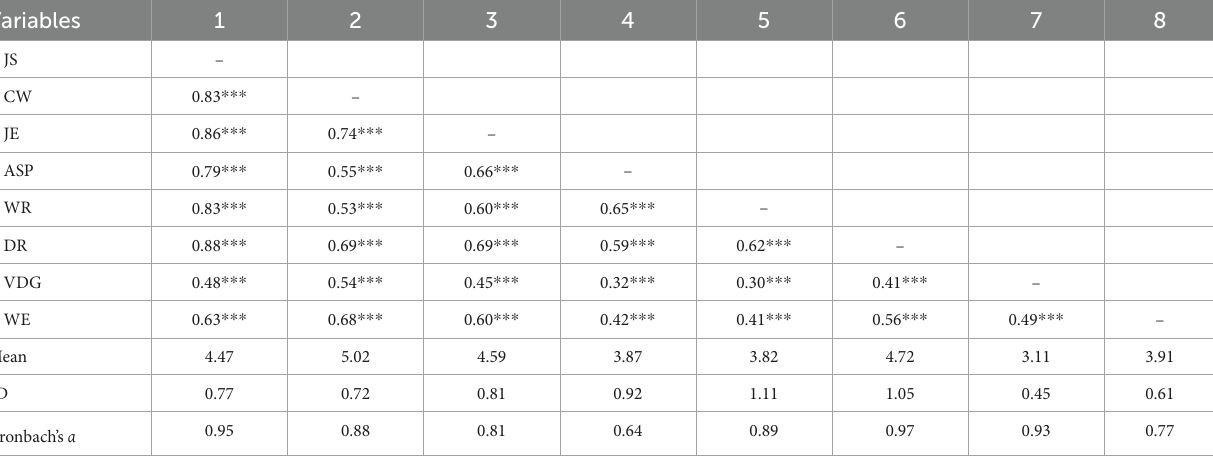
TABLE 2 Correlation analysis among